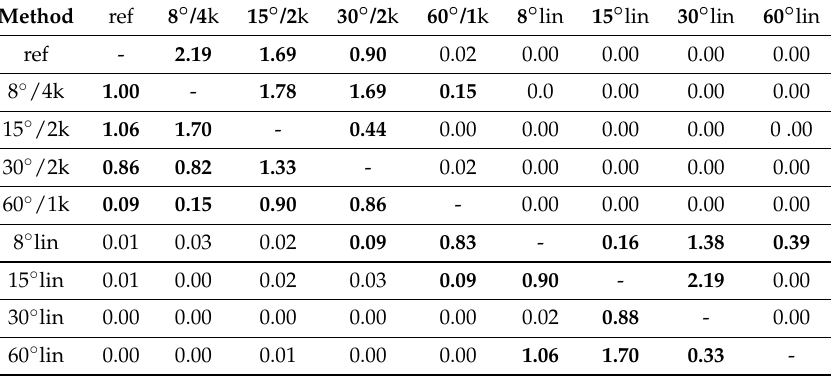
Table 2. p -values (Wilcoxon signed-rank test with Bonferroni–Holm correction) for ratings of continuity in Experiment I. The upper triangle corresponds to the pink noise, the lower triangle to music as source signal. Insignificant differences ( p -values ≥ 0.05) are indicated by bold